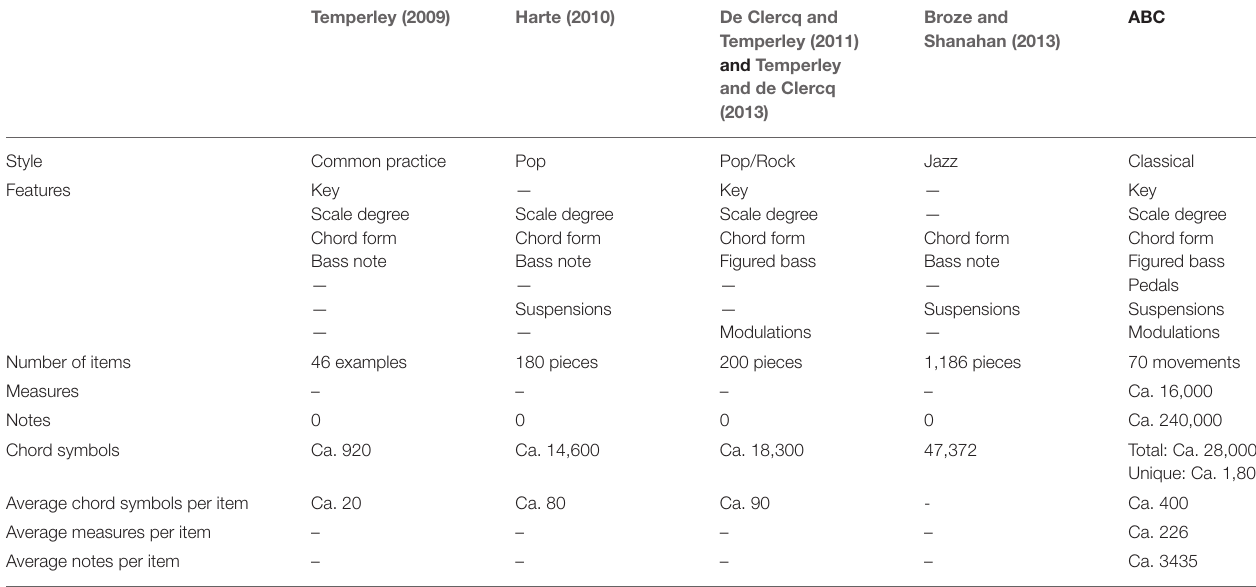
TABLE 1 | Summary statistics of our dataset in comparison with other musical